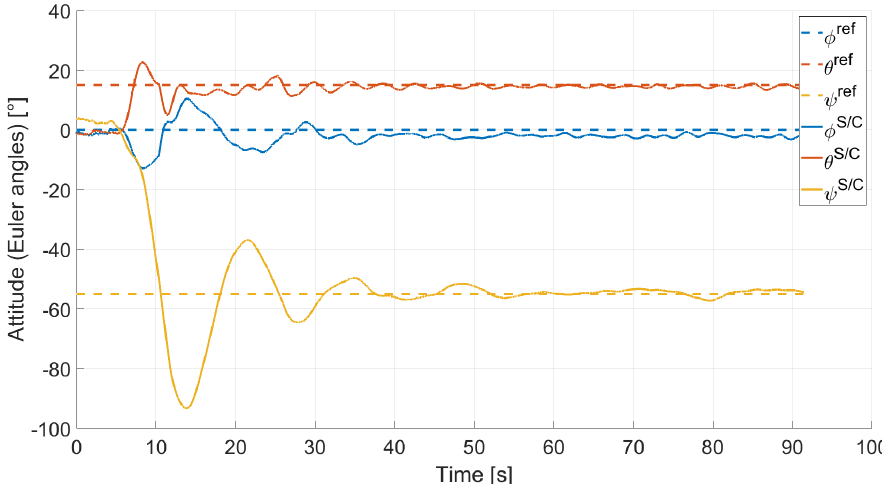
Figure 17. Case 2: attitude as Euler